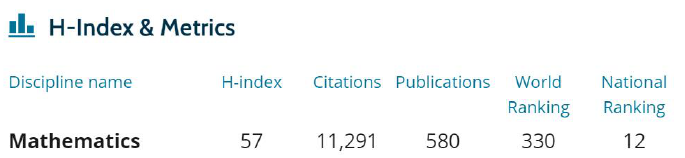
Figure 6. Statistics from Qi’s Research.com profile dated on 2 August